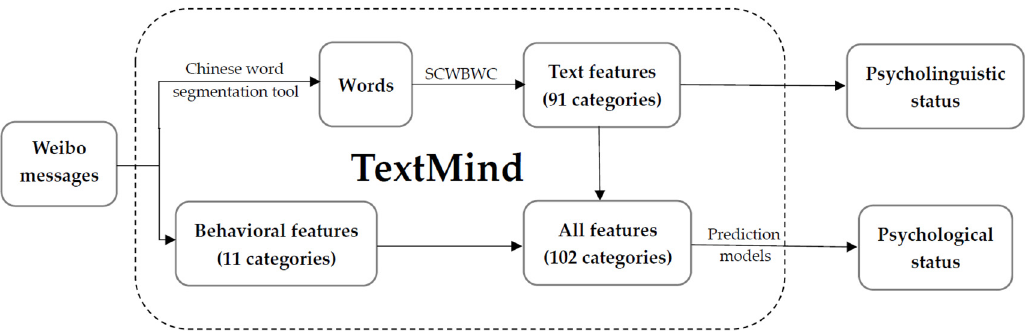
Figure 1. Measurement of psycholinguistic status and psychological status.